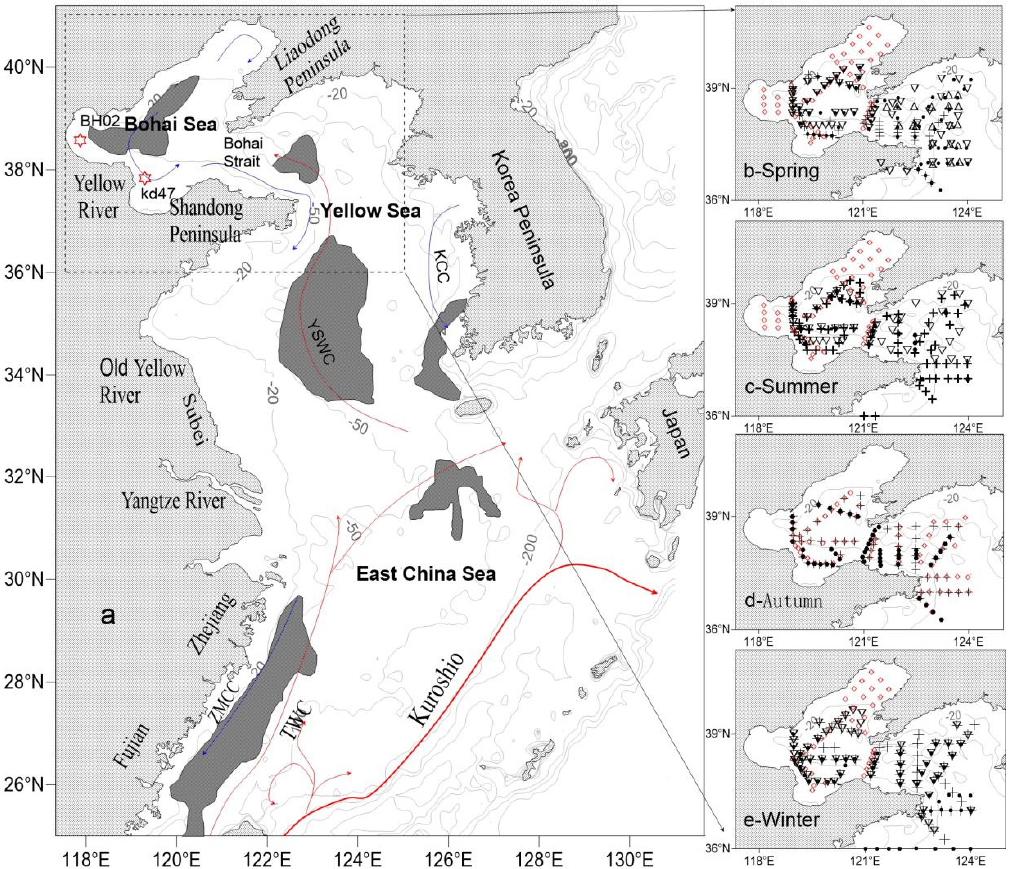
Figure 1. Distribution of observation stations (( a ) study area; ( b ) 5 cruises in spring; ( c ) 4 cruises in summer; ( d ) 4 cruises in autumn; ( e ) 4 cruises in winter). The regions in dark gray indicate the muddy deposition areas.